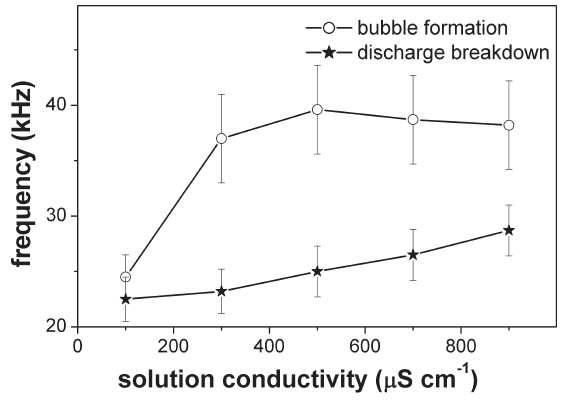
Figure 5: Minimal applied frequency of bubble formation and discharge breakdown as a function of solution conductivity; NaCl solution, dielectric barrier thickness of 0.6 mm, pin-hole diameter of 0.6